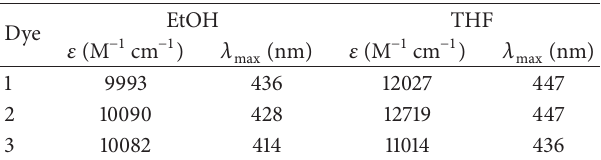
Table 1: Absorption properties of PT1–3 dyes in the EtOH and THF solutions.